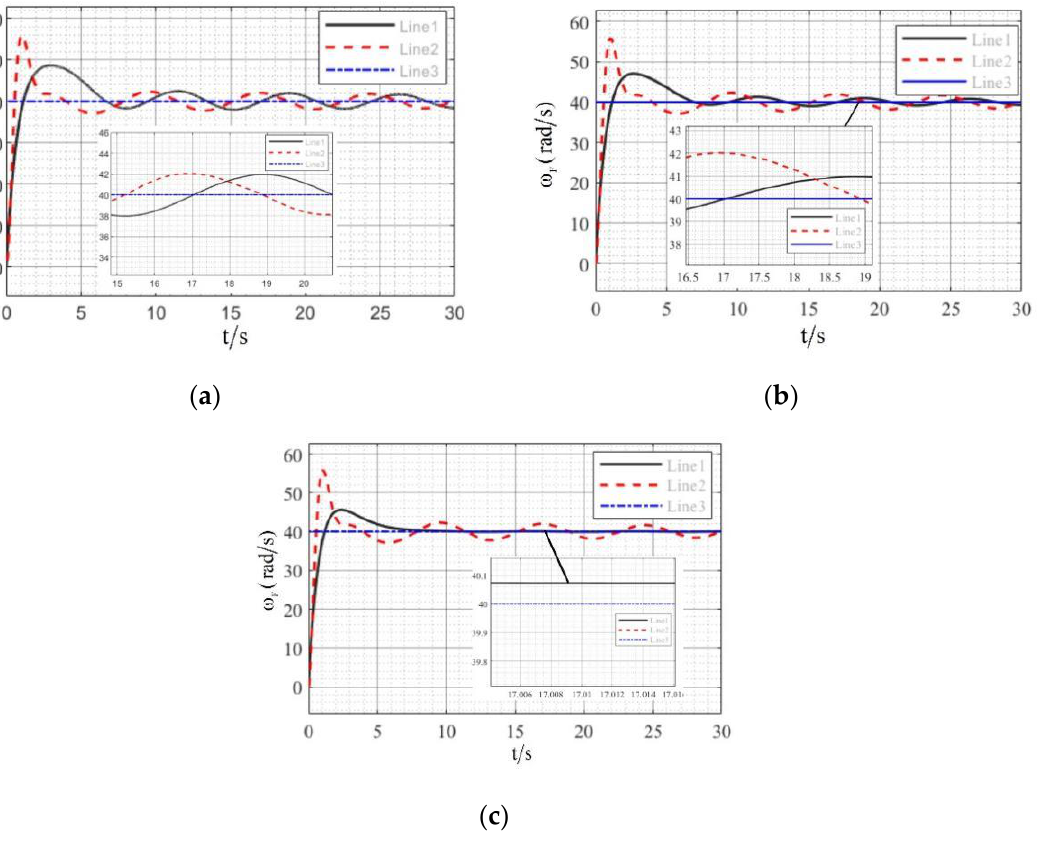
Figure 23. The vibration suppression ability comparison: parameters ( a ) scheme (a); ( b ) scheme (b); ( c ) scheme (c).